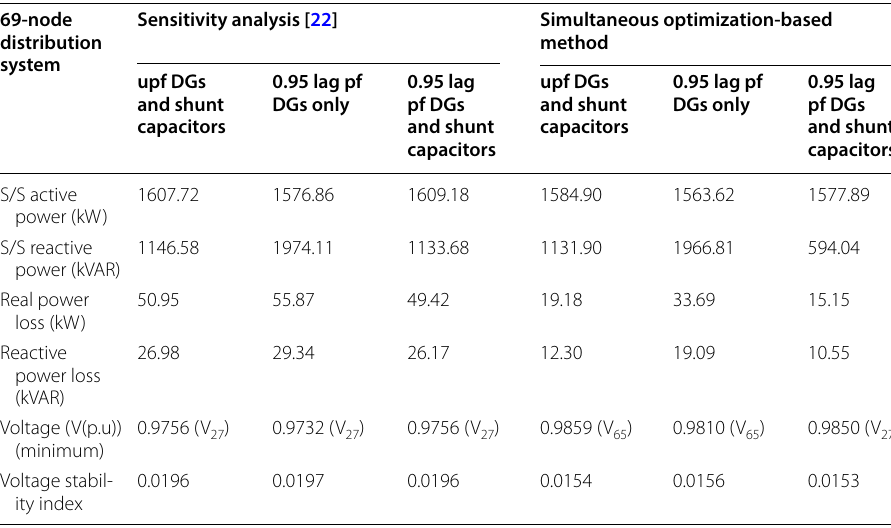
Table 6 Performance of 69-node distribution system 69-node